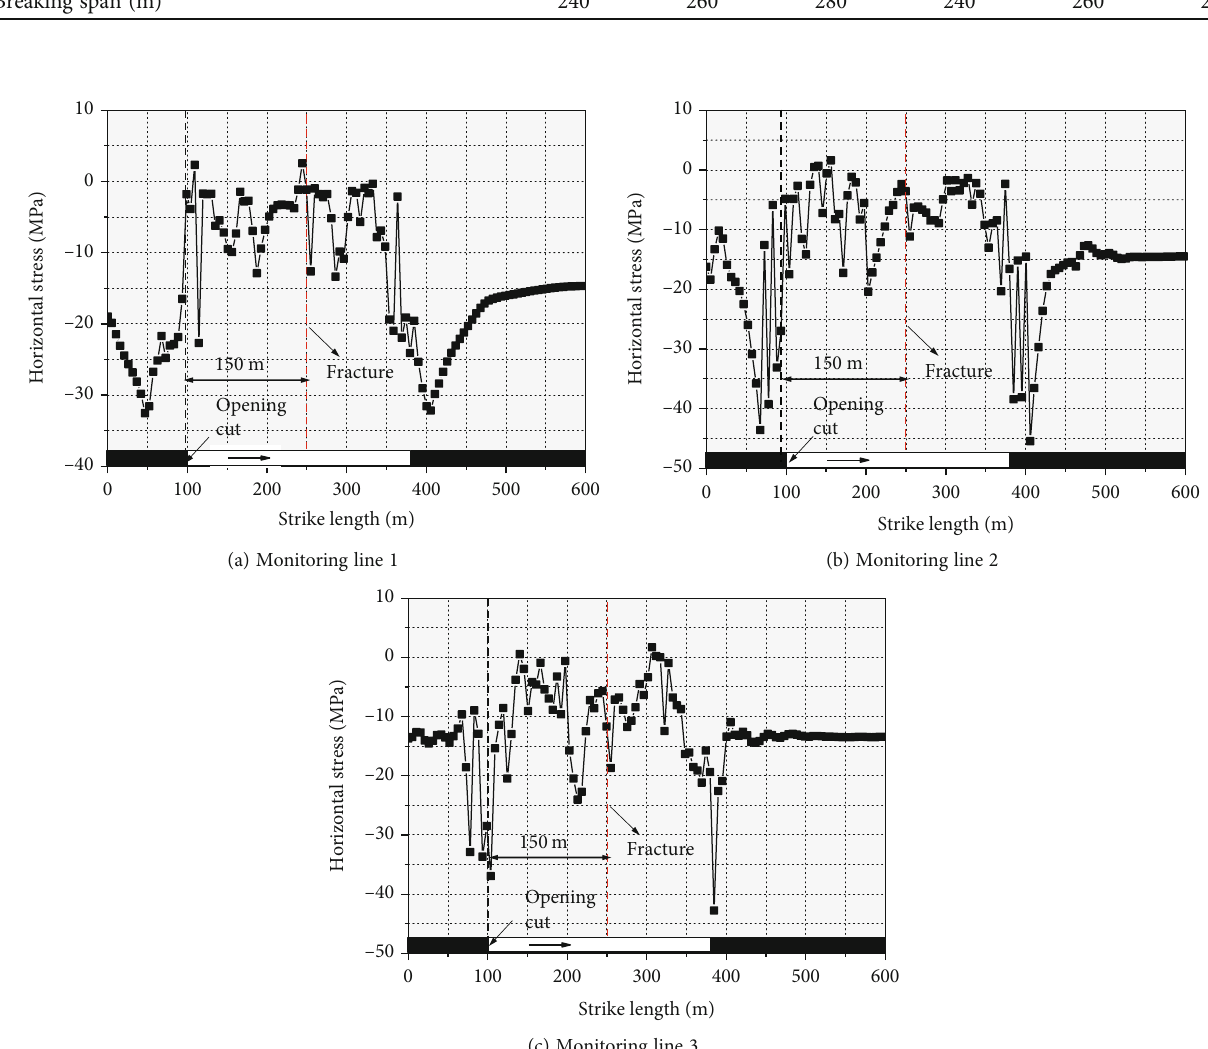
Figure 17: The horizontal stress change curve before the THR breaks (fracture position at 150 m away from the opening